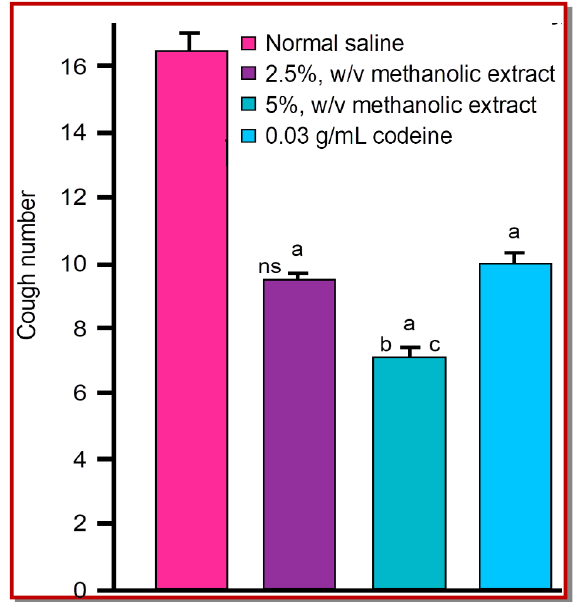
Figure 2: Cough number obtained in the presence of low (2.5%, w/v) and high (5%, w/v) concentrations of methanol extract of Coccinia gran- dis fruits compared to those obtained in the presence of saline (baseline) and codeine phosphate (0.03 g/mL). Statistical differences between plant extracts, standard (codeine) with baseline values; a p<0.001. Statis- tical differences between cough number obtained in presence of plant extracts with that of codeine; ns: non significant difference, b p<0.001. Statistical difference between both the extract concentrations; c p<0.01